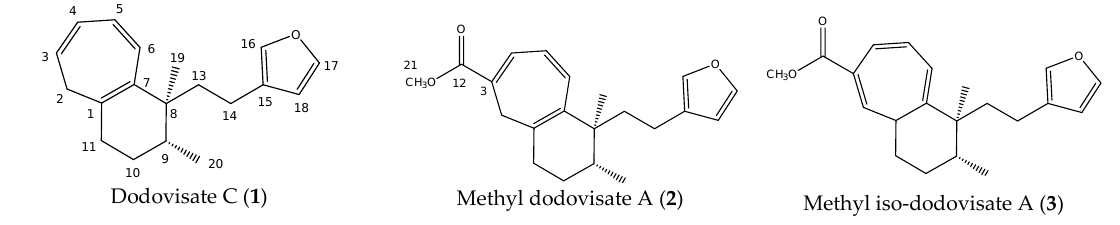
Figure 1. Structure of the three cyclopropylclerodanes isolated from Dodonea viscosa .